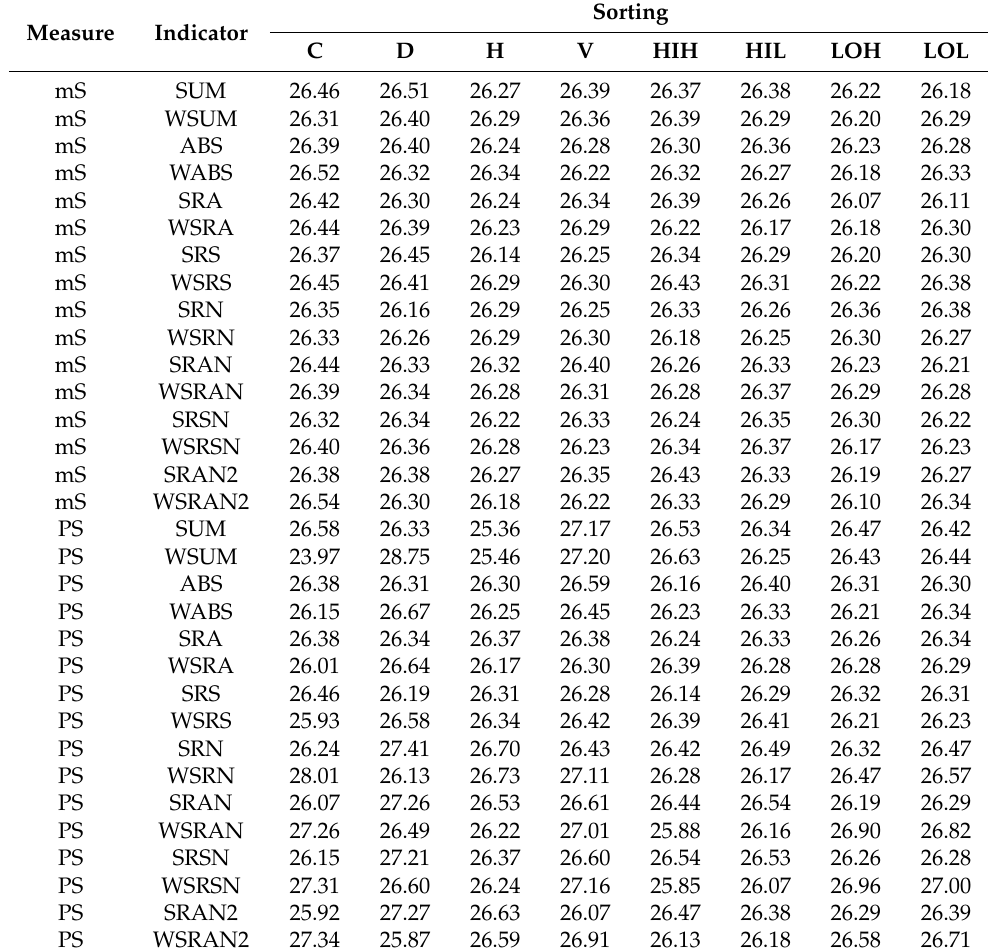
Table 6. Computational results for the dispatching rules: ARPD values II.